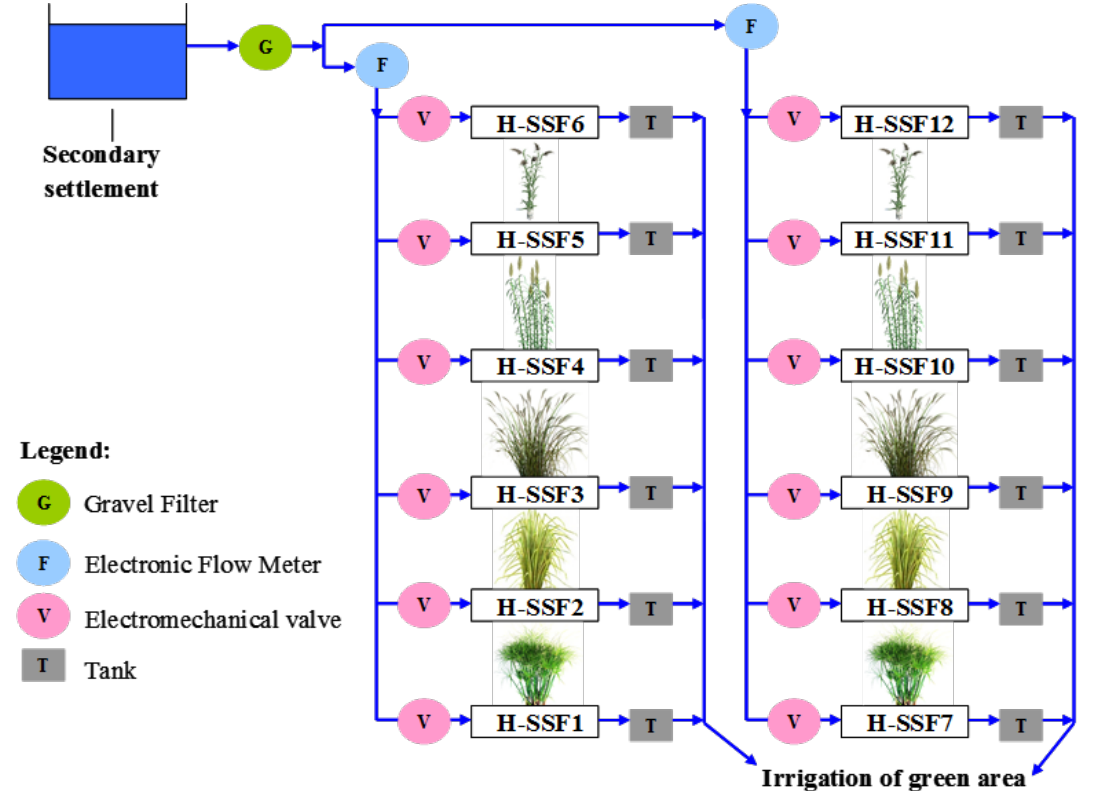
Figure 1. Layout of pilot plant constructed wetland. Cyperus papyrus was planted in horizontal sub surface flow (H-SSF)1 and H-SSF7, Chrysopogon zizanioides in H-SSF2 and H-SSF8, Miscanthus x giganteus in H-SSF3 and H-SSF9, Arundo donax in H-SSF4 and H-SSF10, and Phragmites australis in H-SSF5 and H-SSF11, while H-SSF6 and H-SSF12 are unplanted.